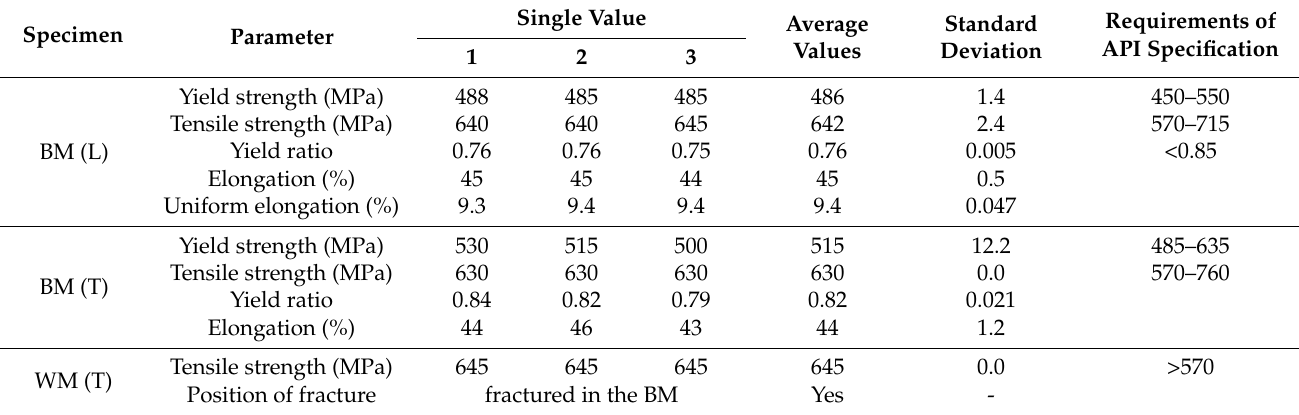
Table 2. Tensile properties of the pipe.